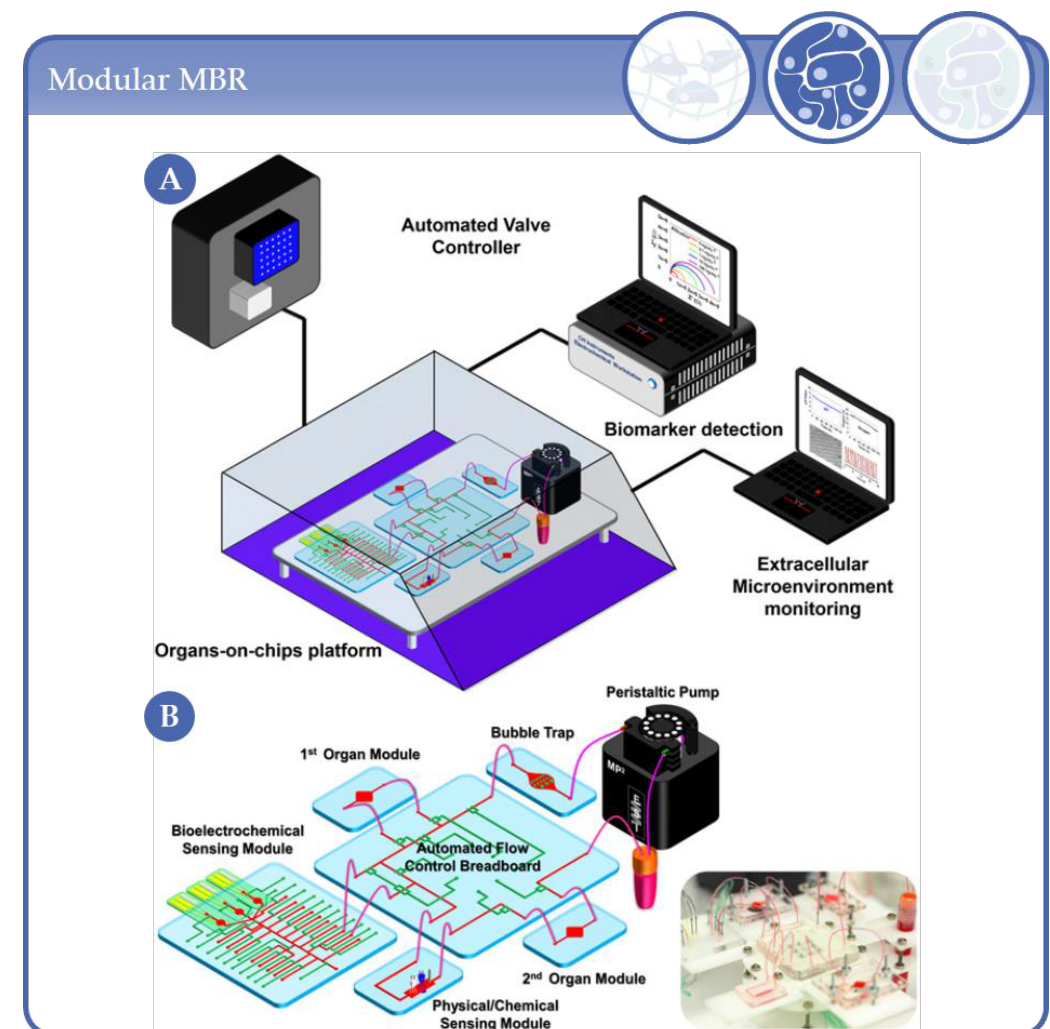
Figure 17. Integrated automated multiorgan-on-a-chip and sensing platform. ( A ) Schematic of a full system where the multiorgan-on-a-chip platform was encased in an in-house designed benchtop incubator, and of automated pneumatic valve controller, electronics for operating physical sensors, potentiostat for measuring electrochemical signals, and computer for central programmed integration of all of the commands. ( B ) Schematic of the integrated microfluidic device consisting of modular components including microbioreactors, breadboard, reservoir, bubble trap, physical sensors, and electrochemical biosensors. Inset shows the photograph of an integrated platform. Schematic view of the integrated multiorgan-on-a-chip system with different micro-bioreactor modules. Reprinted from Zhang et al., PNAS 2017; 114(12):E2294 [159].